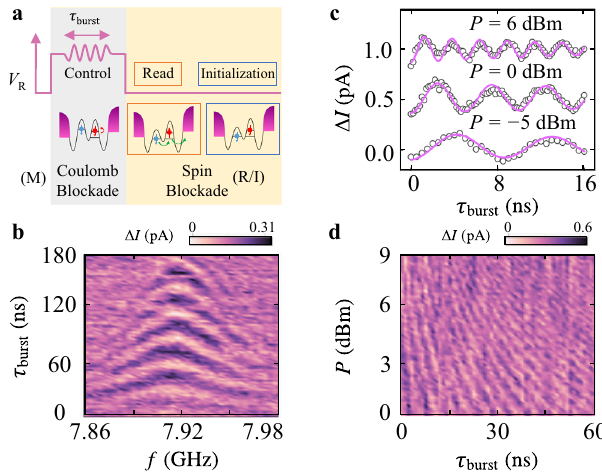
Fig. 2 Ultrafast coherent spin control of mode A. a Schematic representation of the spin manipulation cycle and corresponding gate- voltage ( V R ) modulation pattern. The spin state is fi rst initialized at point I in the PSB regime (Fig. 1b). A pulse then detunes the state to point M in the Coulomb blockade regime for spin manipulation. During this step, a microwave burst with a duration of τ burst is applied to generate spin rotation via EDSR. Afterwards, the system is shifted from Coulomb blockade regime back to spin blockade regime at point R for readout. b At an external magnetic fi eld of B = 100 mT, spin oscillation is observed by sweeping the microwave frequency f and microwave duration time τ burst (the amplitude from the pulse signal generator is set at P = − 15 dBm) applied to the gate R. Each data point is averaged over 20 repetitions. c Rabi oscillations at f = 7.92 GHz with a fi t to A (cid:1) cos ð 2 π f Rabi τ burst þ φ Þ (cid:1) exp ð(cid:3)ð τ burst = T R (An offset of 0.5 pA is set between two oscillations for clarity). Rabi frequencies are 112 ± 2, 202 ± 2 and 393 ± 2 MHz from bottom to top. We correct the data by removing the background current I 0 . Similar results for mode B are shown in Supplementary Fig. 7.1. To mitigate the effects of charge noise, we average the current over 100 repeated cycles for each data point (Supplementary Fig. 5). d Rabi oscillations under different microwave power P